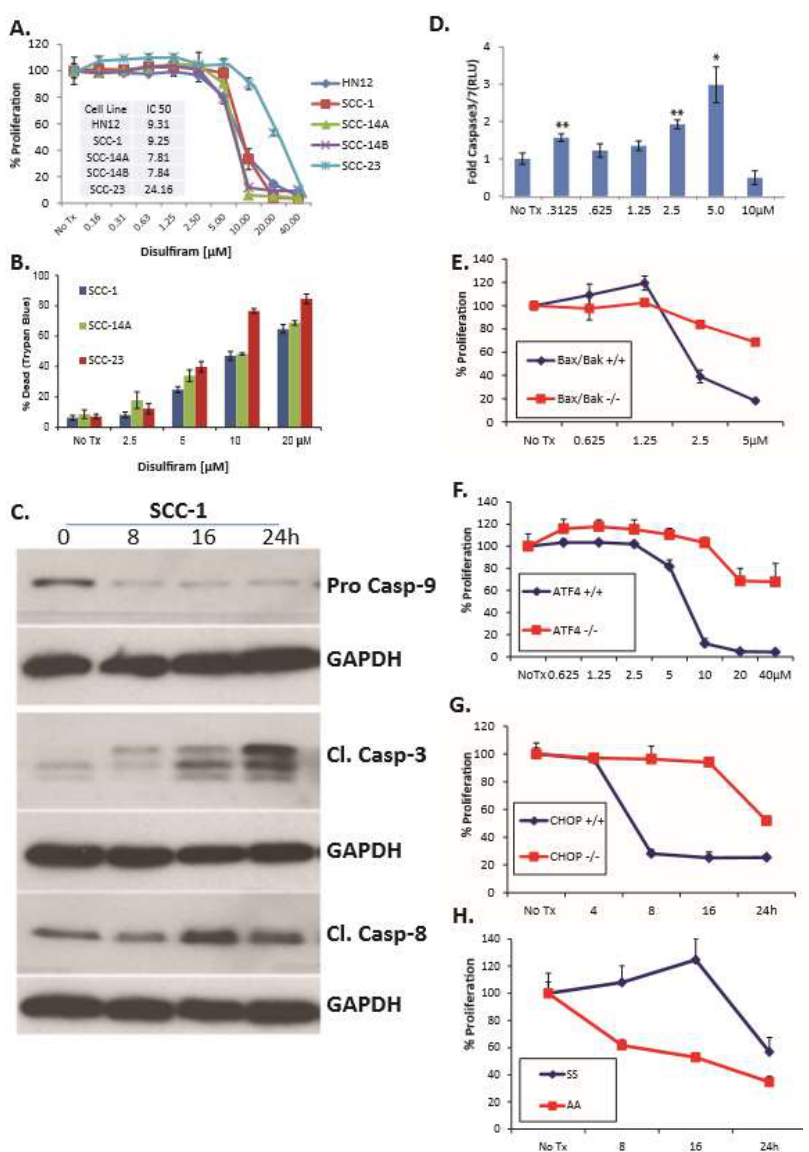
Figure 3. DSF induces UPR-dependent apoptosis and reduces proliferation in OSCC. ( A ), A panel of OSCC cells treated with increasing doses of DSF for 24 h evaluated with an ATP-based luminescent proliferation assay; data are representative of multiple experiments; error bars represent standard deviation. ( B ), Similarly treated cell lines evaluated after 24 h with trypan blue exclusion assay to appreciate relative levels of live and dead cells; error bars represent standard deviation. ( C ), Immunoblot analysis of caspases in whole cell lysates from SCC-1 cells treated with 10 µ M DSF. ( D ), Luminescent real-time measurement of caspase3 / 7activation in MEFs treated for 4h; error bars represent standard deviation. Two-tailed test: * p ≤ 0.05, ** p ≤ 0.01, *** p ≤ 0.001. ( E – H ), ATP-based proliferation assays in MEF treated with 5 µ M DSF. Bax / Bak double-null MEF; Two-way ANOVA, p ≤ 0.0001 for concentration and interaction, Atf4 -null MEF; p < 0.0001 for concentration and interaction. Chop -null MEF; p ≤ 0.0001 for time and interaction and eIF2 α Ser51-Ala mutant (A / A) MEF; p ≤ 0.0001 for time and interaction. Wildtype controls were littermate matched MEFs; error bars represent standard deviation.